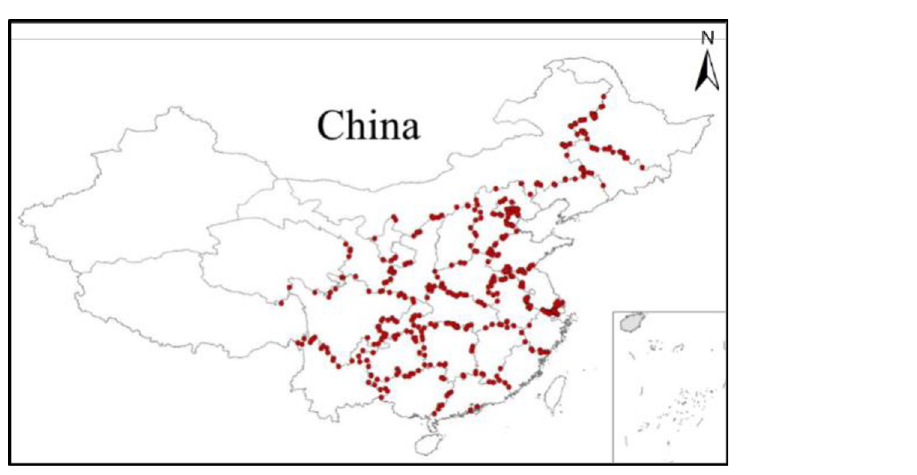
Fig 1. Distribution of water quality monitoring stations at provincial boundaries in 2019 [15].